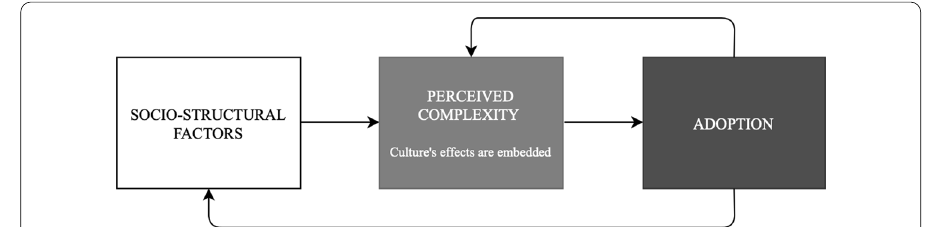
Fig. 1 Relationship between the investigated dimensions: The FACOPA